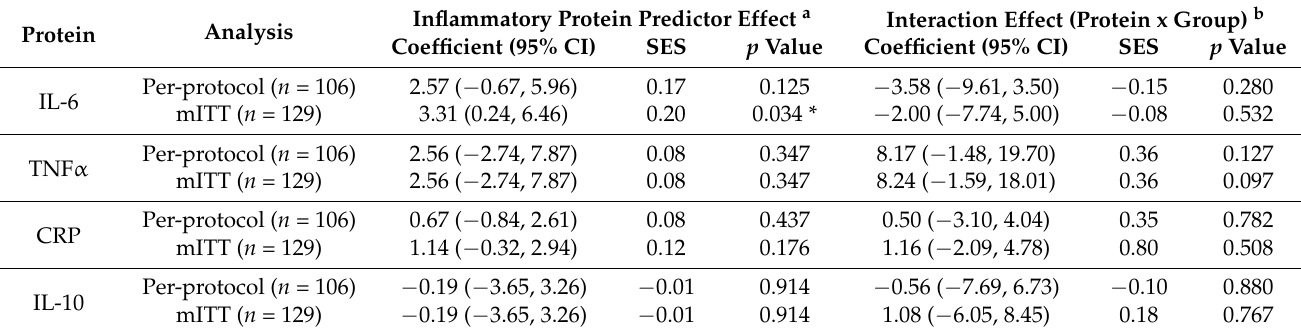
Table 3. Predictive effects of inflammatory proteins on subsequent outcome to metyrapone versus